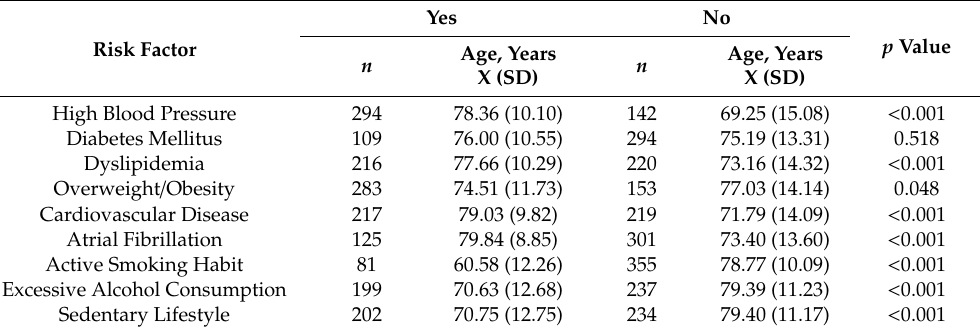
Table 2. Comparison of the presence of acute stroke risk factors (RFs) based on age, using independent samples Student’s t